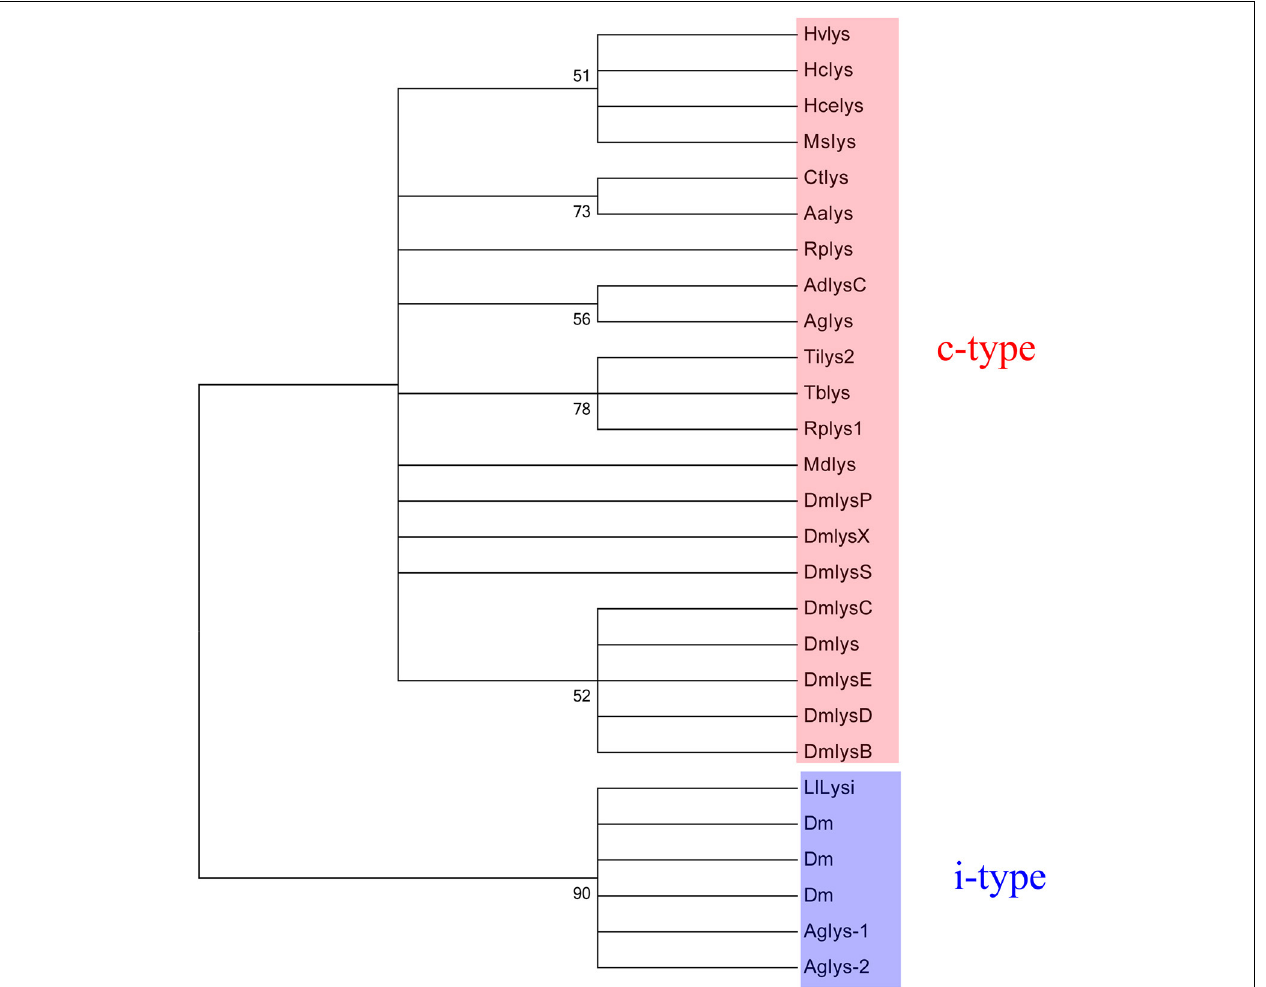
FIGURE 3 | Cladogram of selected insect GH22 protein sequences (c and i-type lysozymes) and LlLysi. Sequences are from: Anopheles darlingi (accession number AAB61345), Anopheles gambiae (AAC47326; AY659931; EF492429), Drosophila melanogaster (AAF47445; AAF47453; CAA21317; AAF57939; AAF57940; AAF47452; AAF47451; AAF47450; AAF47449; AAF47448; CAA80225), Heliothis virescens (AAD00078), Hyalophora cecropia